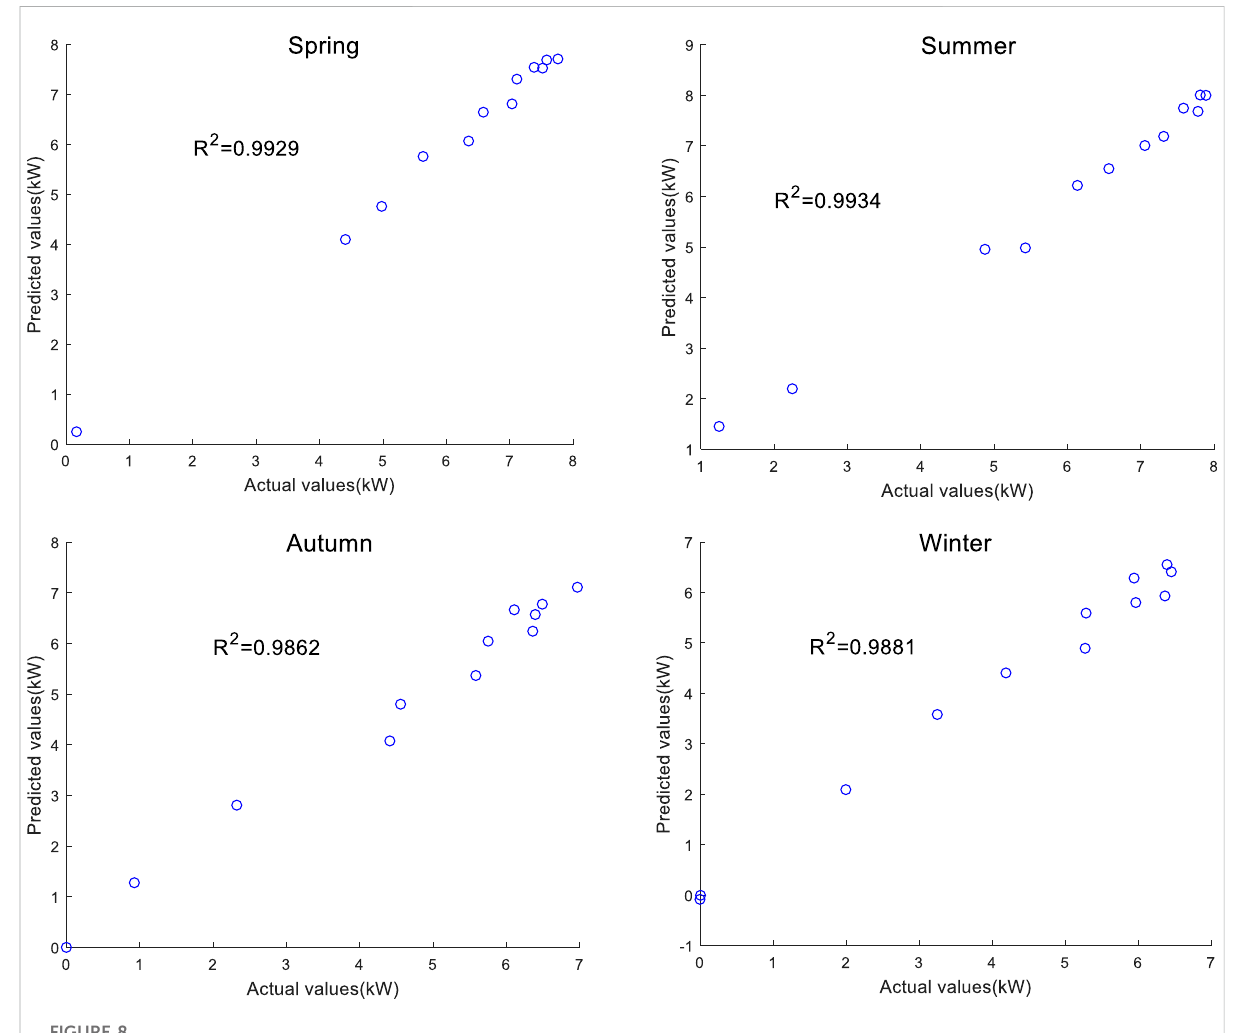
FIGURE 8 The correlation between the predicted power of KM-SDA-ABWO-RBF and the actual power.